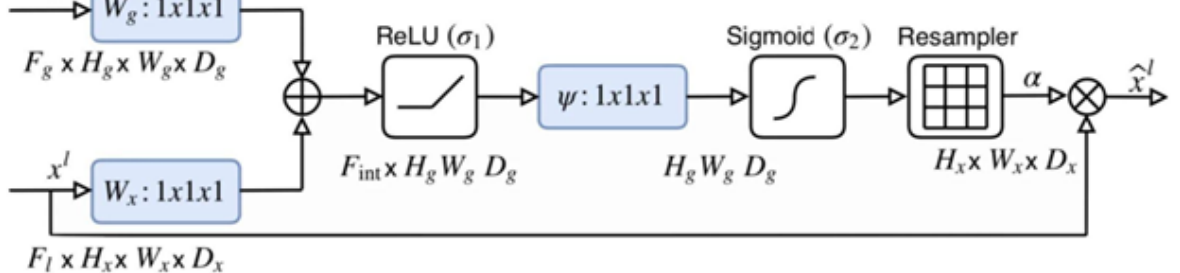
Figure 4. Attention mechanism.